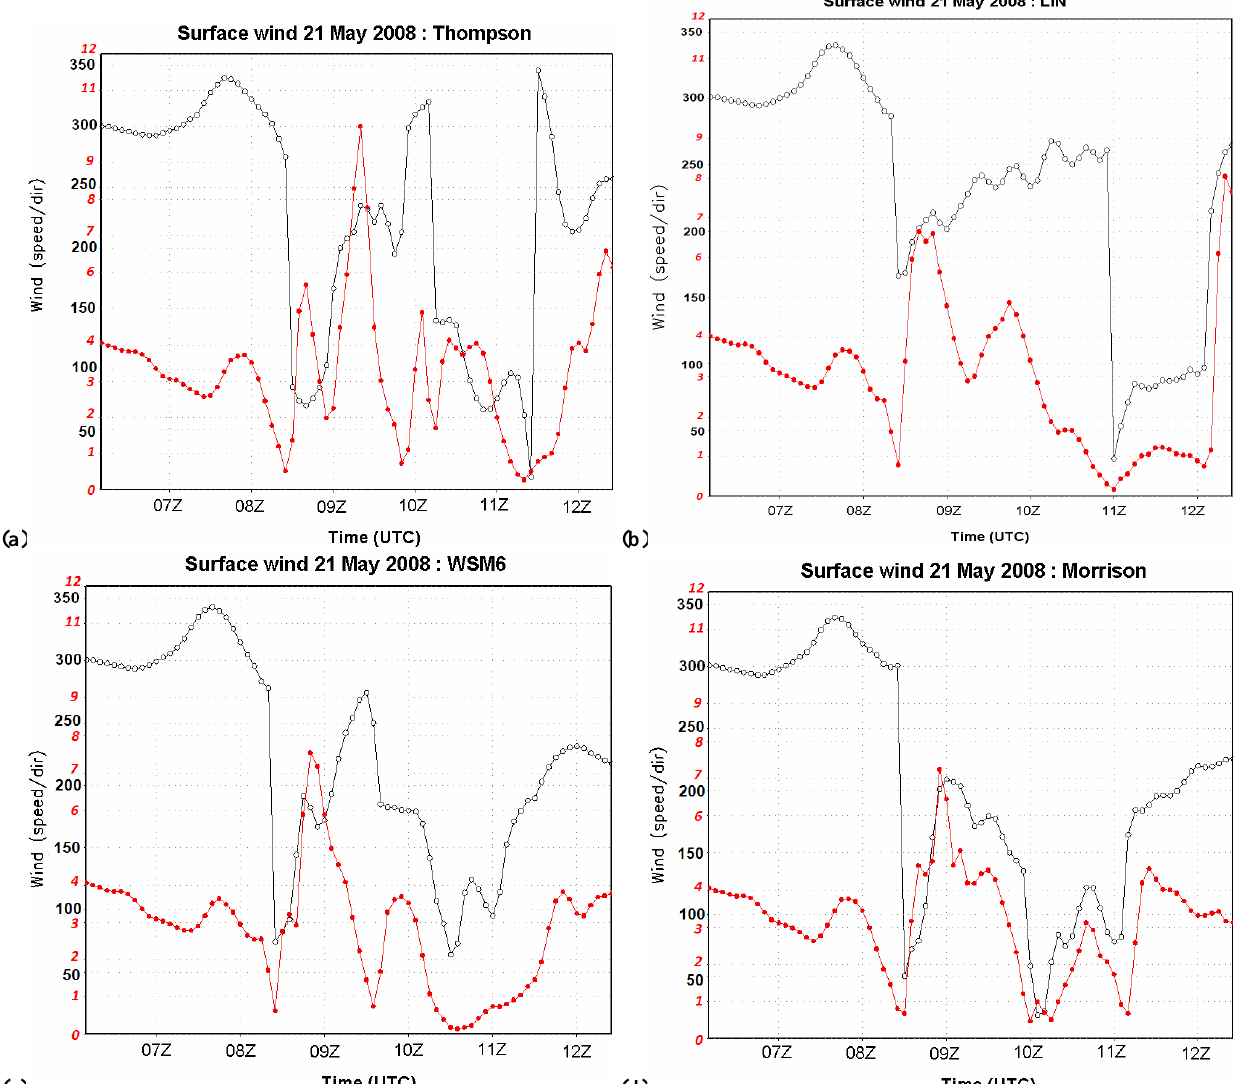
Fig. 9. Surface wind direction (black) and speed (ms − 1 ) (red) at Gadanki simulated by the model with four different MP Schemes (a) Thomp- son, (b) Lin, (c) WSM6, and (d)